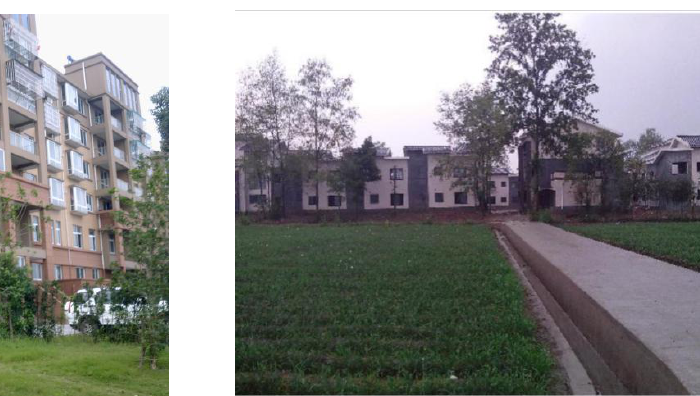
Fig. A3.1: Rural living environments before rural renewal